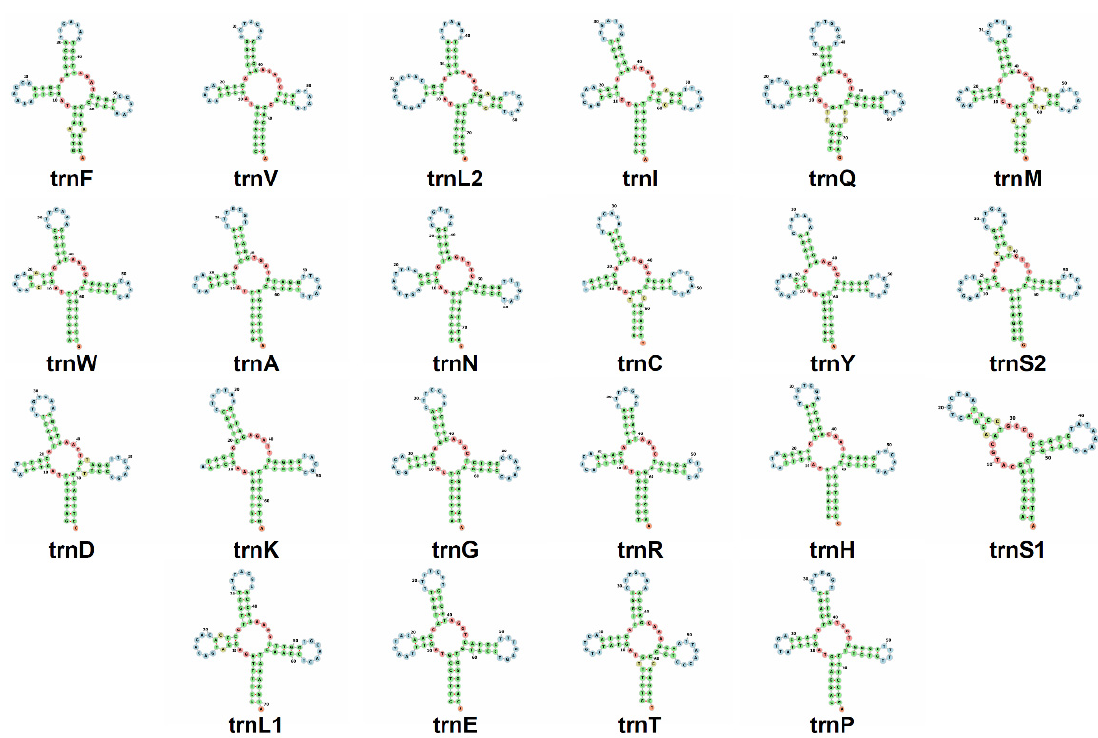
Figure 5. Secondary structure of tRNAs in the mitochondrial genome of the Java pangolin ( Manis javanica) . Out of 22 tRNA genes, 19 exhibit a ‘cloverleaf’ secondary structure. tRNA-Ser1 invariably lacked the entire dihydroxyuridine (DHU) arm (stem + loop), while tRNA-C and tRNA-K lacked the dihydroxyuridine (DHU) loop but not the stem. Secondary structures visualized in the Forna web server.